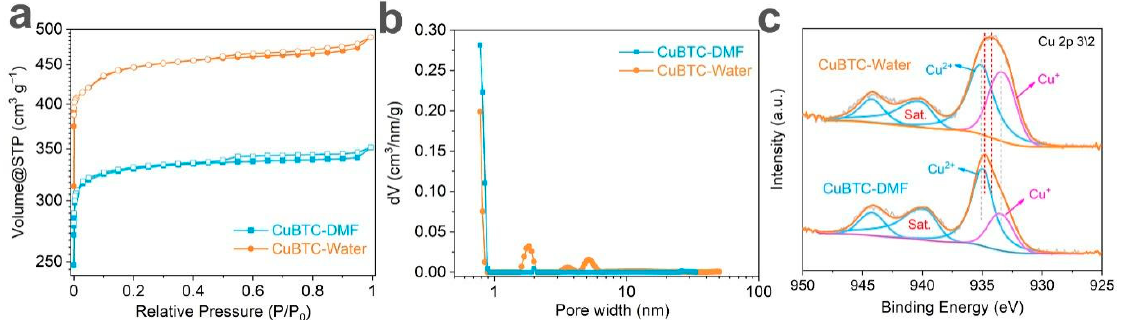
Figure 2. ( a ) N 2 adsorption and desorption isotherms of CuBTC-DMF and CuBTC-Water at 77 K and ( b ) corresponding pore distributions calculated using NLDFT method. It should be noted that